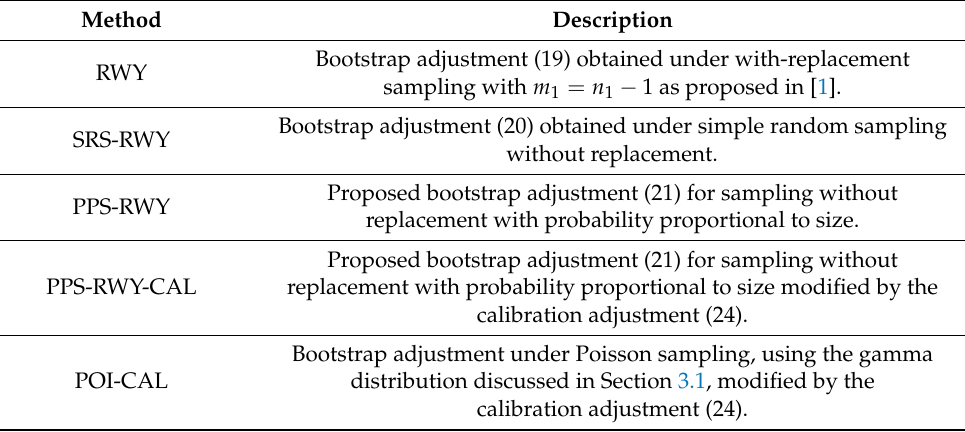
Table 1. Bootstrap methods for single-stage cluster